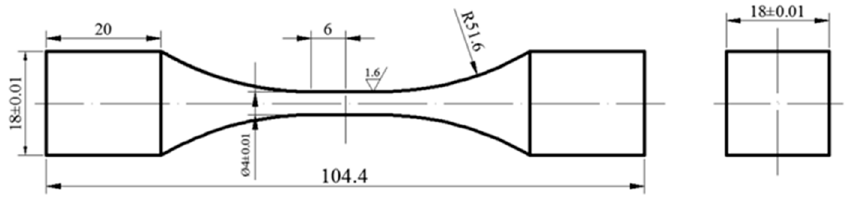
Figure 1. Geometry of the axial fatigue specimen (in mm).